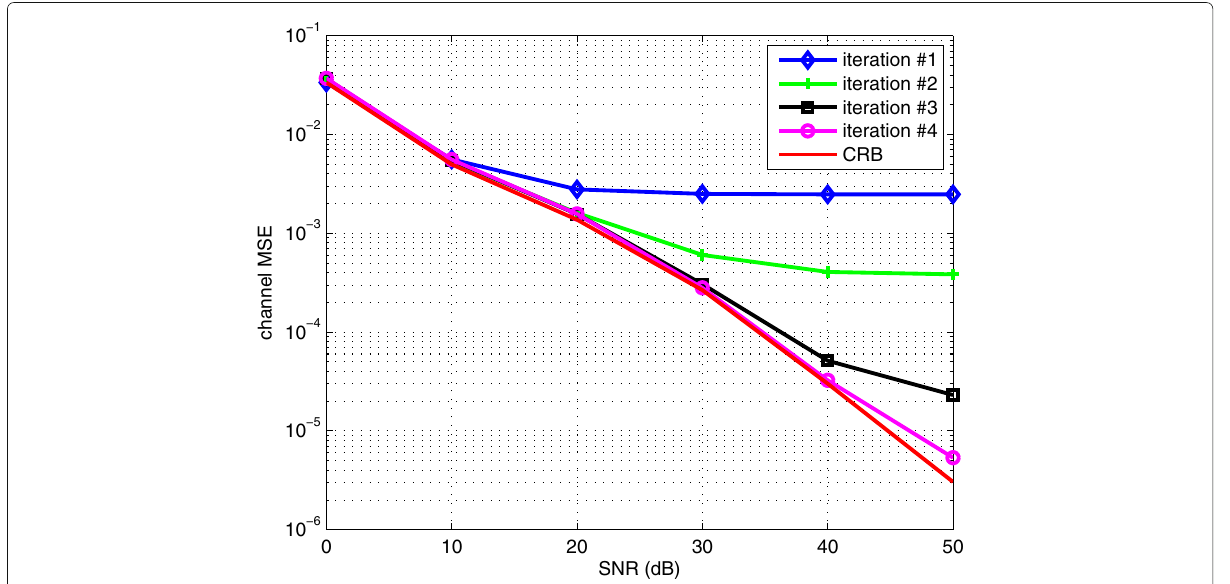
Fig. 5 Performance of the CML estimator as a function of the SNR for SIR = 5 dB, K = 4